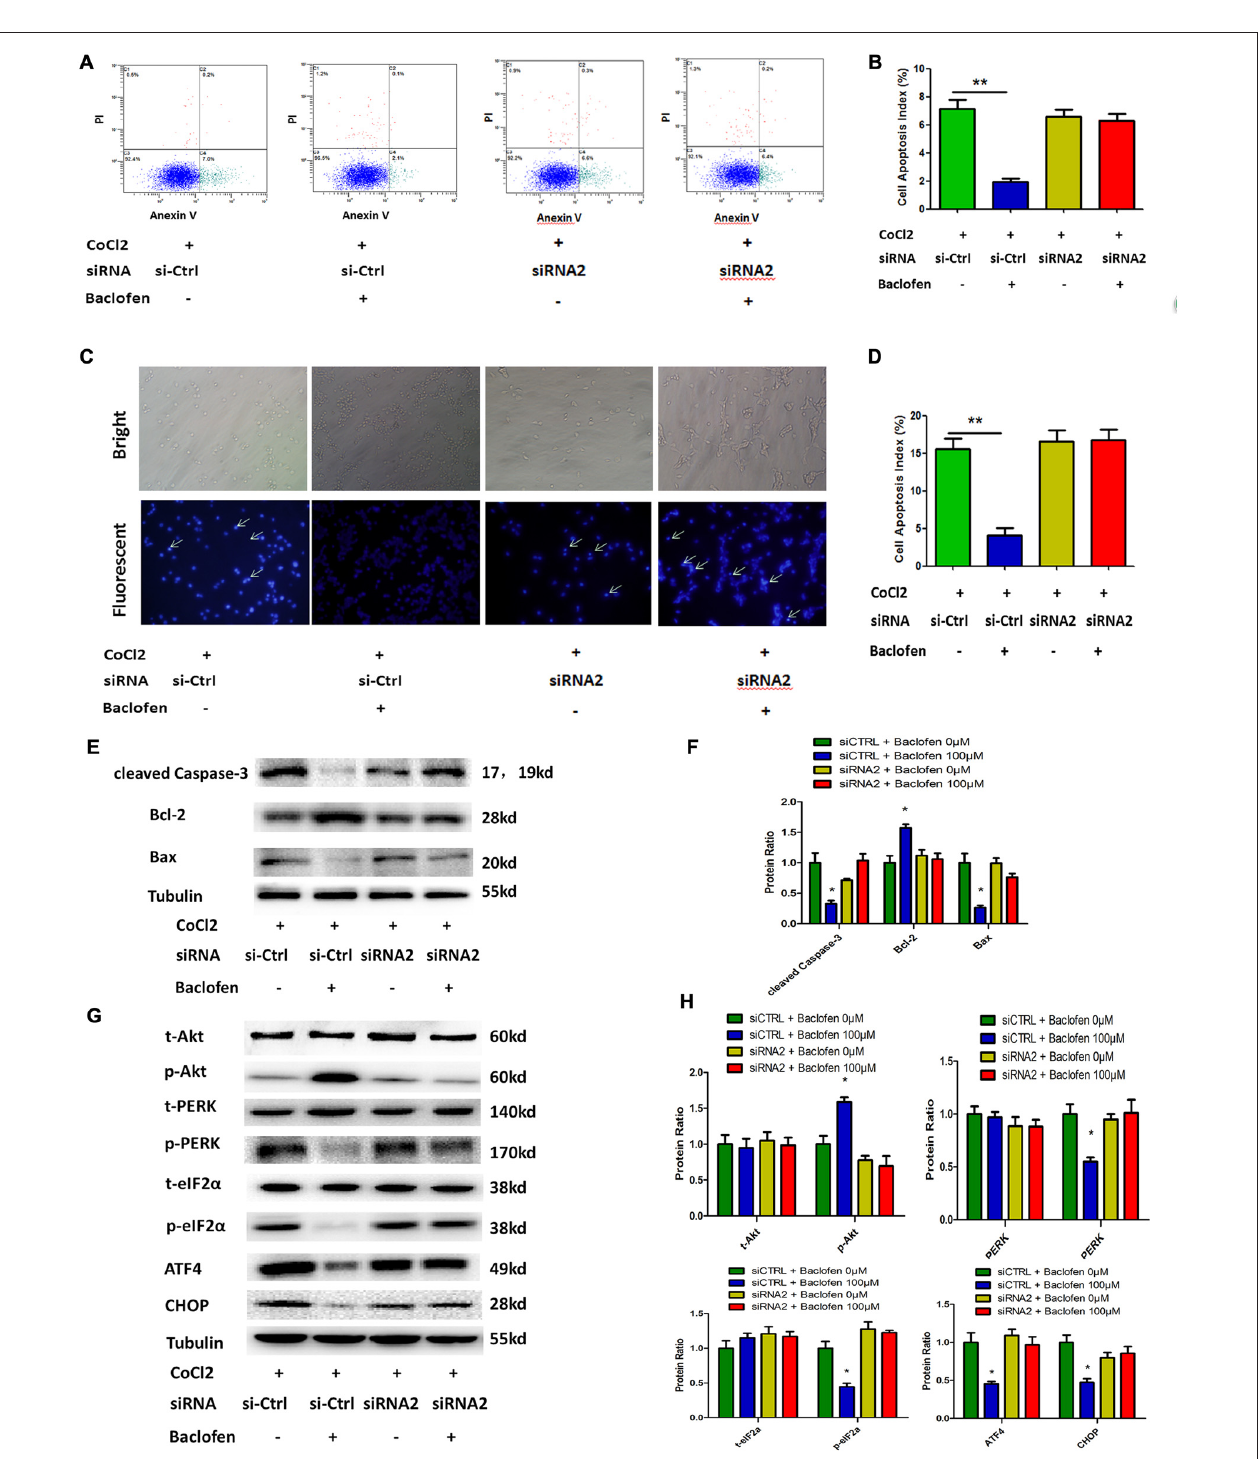
FIGURE 5 | Baclofen mediated RGCs apoptosis via GABA B receptor. (A,B) RGCs were transfected with GABA B 2 siRNA2 or control siRNA before treatment with CoCl 2 and baclofen for 24 h as indicated. Cell apoptosis detected by Annexin V and PI staining methods. C2, C4 quadrant (Annexin V + /PI − ) indicate the percentage of necrotic or apoptotic cells, respectively. Values represent the mean ± SD of three independent experiments. ∗∗ P < 0.01 vs. basal level. (C,D) RGCs stained with Hoechst nuclear stain after treatment as described above. White arrows indicate the apoptotic nuclei. Values represent the mean ± SD of three independent experiments. ∗ P < 0.05 vs. basal level. (E–H) RGCs were transfected with GABA B 2 siRNA2 or control siRNA before treatment with CoCl 2 and